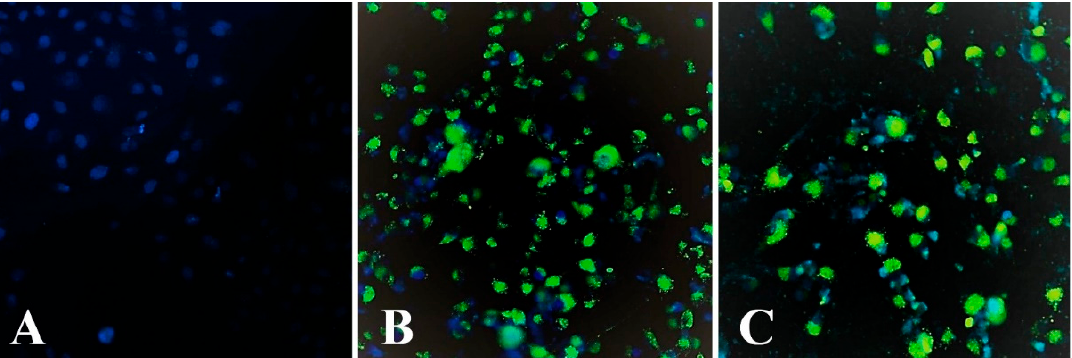
Figure 10. Uptake of the Em-GFP ( A ), E2-13W4 protein ( B , C ) by U87MG cells during 24-h incubation without ( B ) and with ( C ) 2 µM Mn 2+ . The green colour indicates protein and the blue colour indicates cell nuclei stained with DAPI.